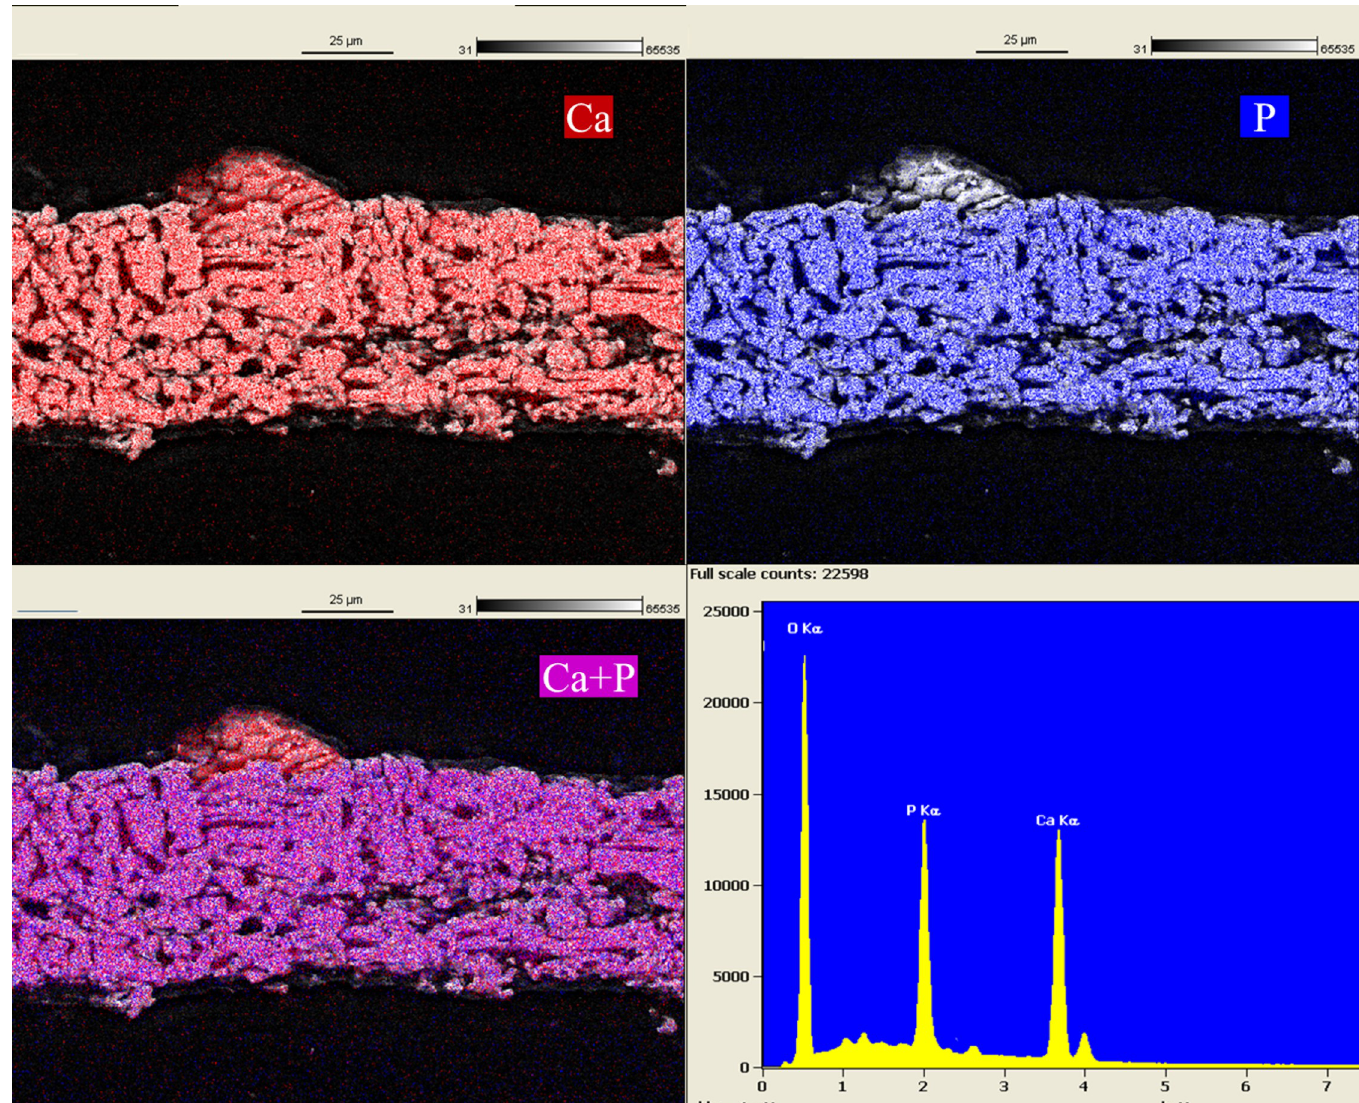
Fig 13. SEM-EDS maps and spectrum from the same section of a Daily PEMF ring construct in Fig 11 with emphasis on Ca, P localization, and their overlay. Ca/P ratio = 1.46. SEM settings: EHT = 15KeV, WD = 10.7 mm, H = 128.3 μ m, W = 171.0 μ m.